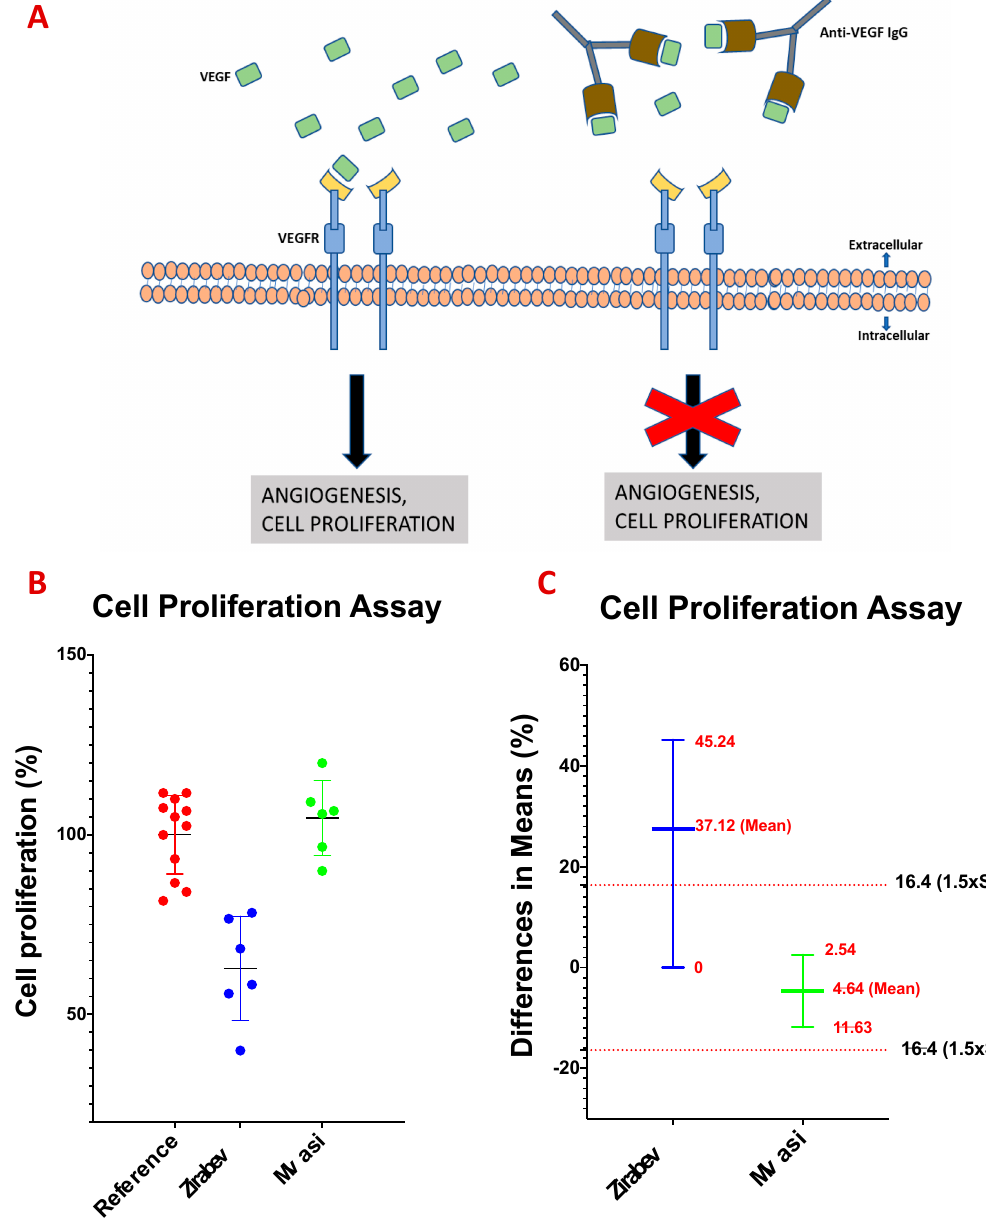
Figure 9. Inhibitory effect of samples on VEGF-induced HUVEC proliferation. ( A ) Schematic illustration of the action mechanism of anti-VEGF antibody. ( B ) Comparison of the potency of originators and biosimilars was represented as relative proliferation (%). Each sample was analyzed in triplicate. ( C ) Equivalence test results represent the differences in means of biosimilars comparing the originators.